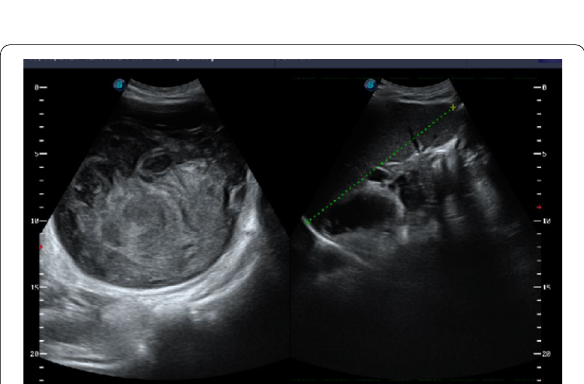
Fig. 4 Ultrasound images of a heterogeneous mass lesion measuring 11.6 12.9 13.6 cm in mid abdomen extending into lower × ×